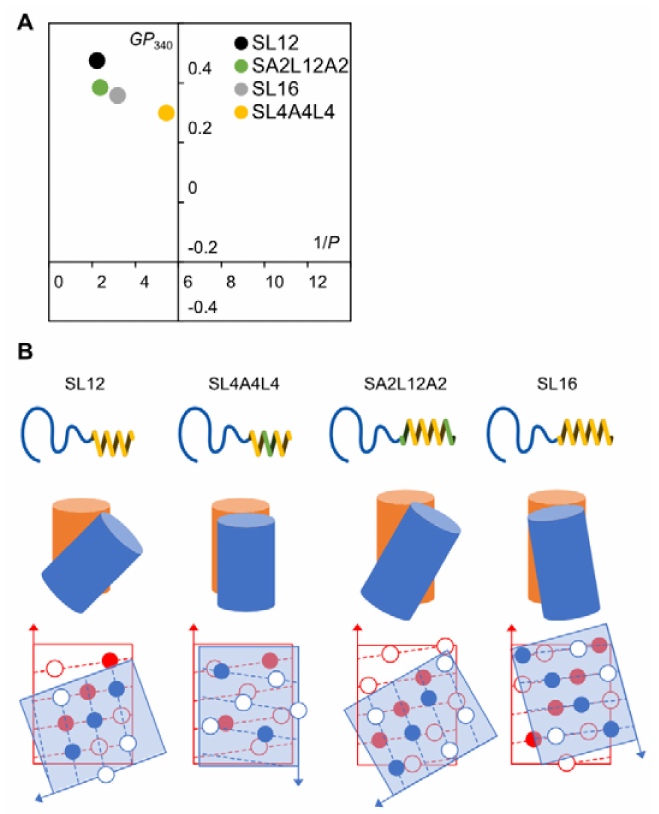
Figure 4. Cartesian diagram ( A ) and schematic illustration of the helix packing models ( B ) in peptide assemblies prepared from SL12, SL4A4L4, SA2L12A2, and SL16. The arrows in the helical net diagrams indicate the orientation from the C - to N -terminal. In the packing model ( B ), the orange and blue cylinders represent hydrophobic α -helical blocks of amphiphilic polypeptide and their neighbors,